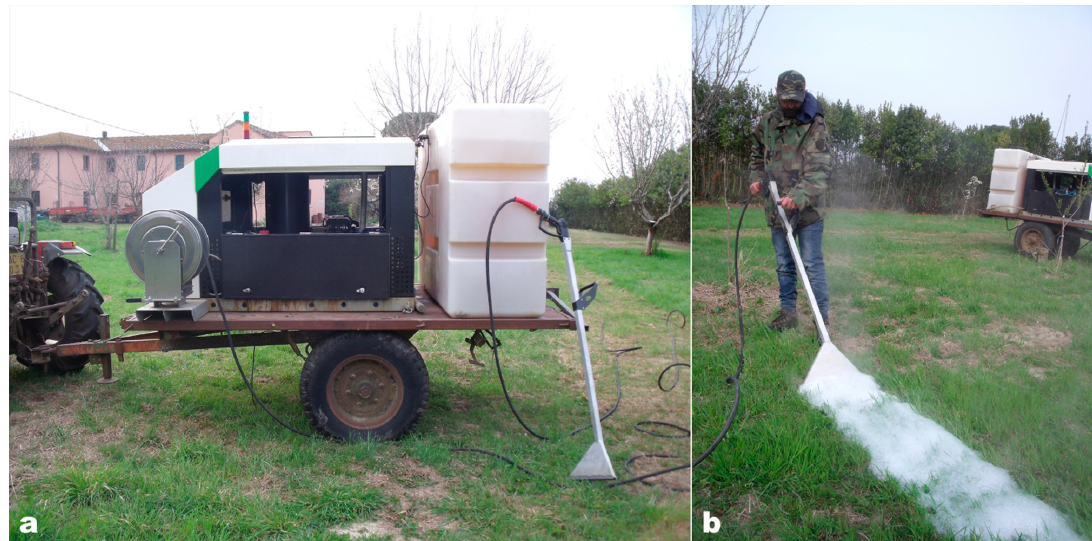
Figure 1. Hot foam machine: ( a ) lateral view of the machine with the 1000 L water container, the 300 mm wide manual foam hot foam distribution tool, and the covered part containing the foam container, the boiler, the programmable logic controller, the pump and the diesel generator set; ( b ) hot foam distribution tool and example of a hot foam